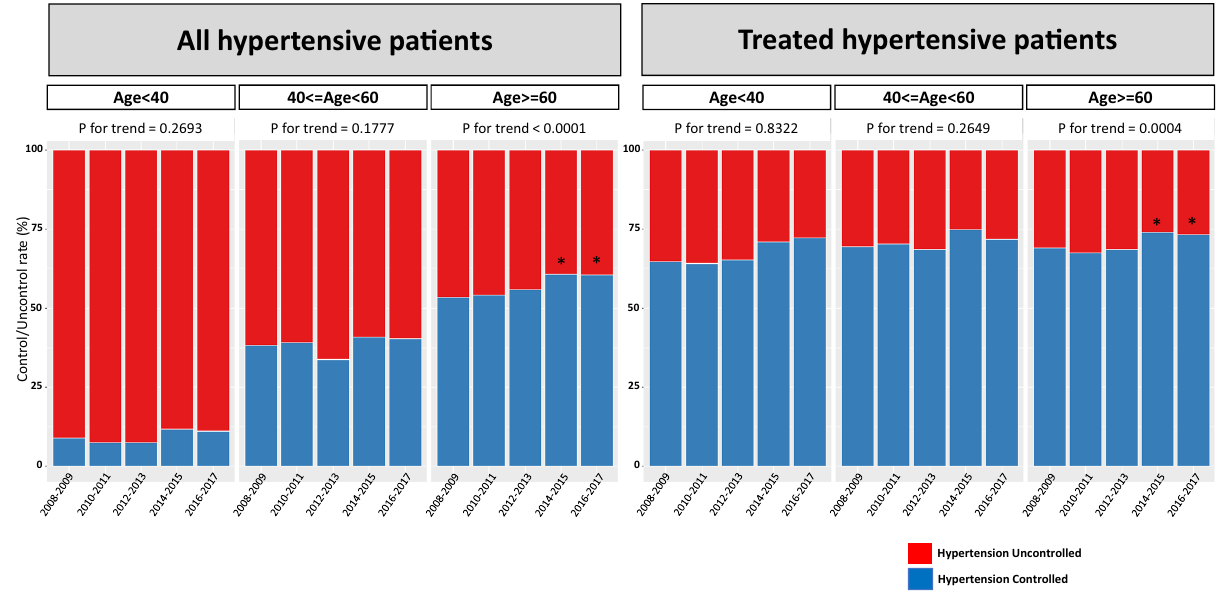
Figure 3. Hypertension control rate according to age group. The hypertension control rate is higher in middle age (40–60 years) and older age (≥ 60 years) group compared with younger age (< 40 years) group. However, among the treated patients, there was no significant difference according to age group. Hypertension control rate has been improved among the older age (≥ 60 years) group; however, there was no significant improvement in other age group. *p < 0.05 compared with 2008–2009. Trend analysis was performed by regression analysis and age-adjusted P values are